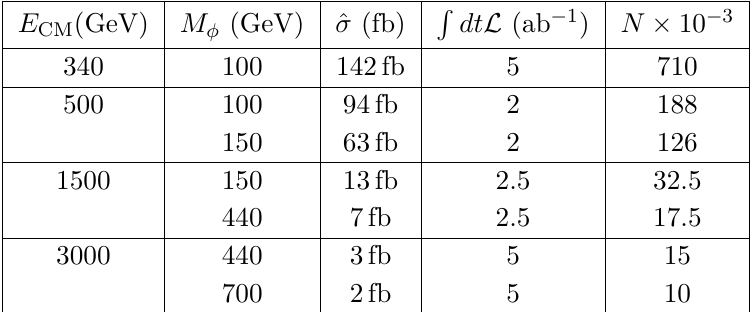
Table 1 . Comparison of a circular e + e (cid:0) collider and two linear e + e (cid:0) options (ILC-500 and CLIC) for neutral current production of a (cid:30) + (cid:30) (cid:0) pair for representative choices of M (cid:30) . Final column con- tains the expected number of signal events ( N ) for the given cross section and integrated luminosity.